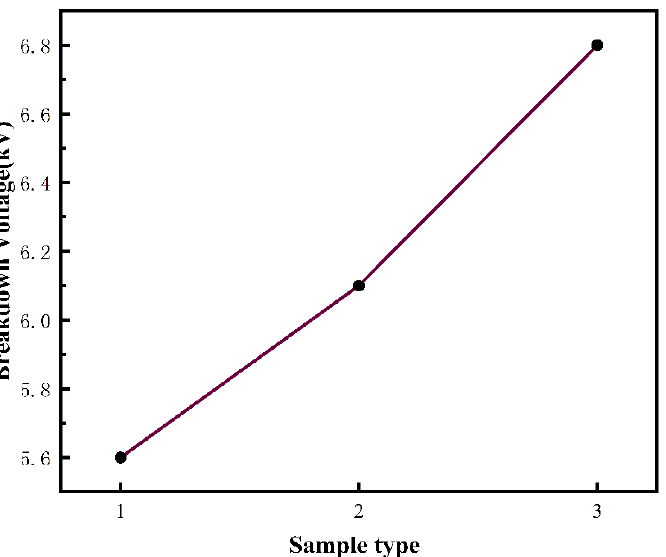
Figure 11. Breakdown voltage of different samples (1 — insulator; 2 — PDMS/insulator; 3 — FAS-17- modified nano-SiO 2 PDMS/insulator).